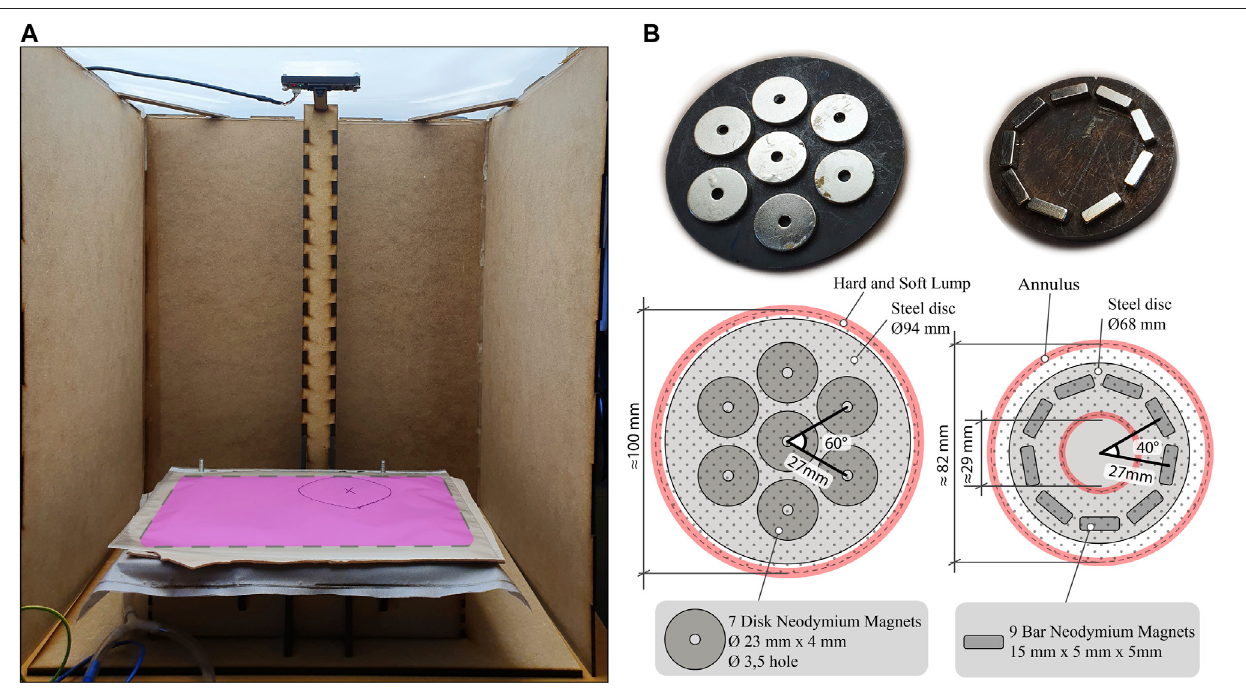
FIGURE 6 | (A) Test rig with camera and cabinet setup (pink area is the palpable fi eld) (B) Magnet arrangement with angular and radial distance shown. Approximated outlines for the generated outputs are also illustrated with measurements. (Left) Circular shape for Hard and Soft Lump (Right) Annulus shape with the hollow